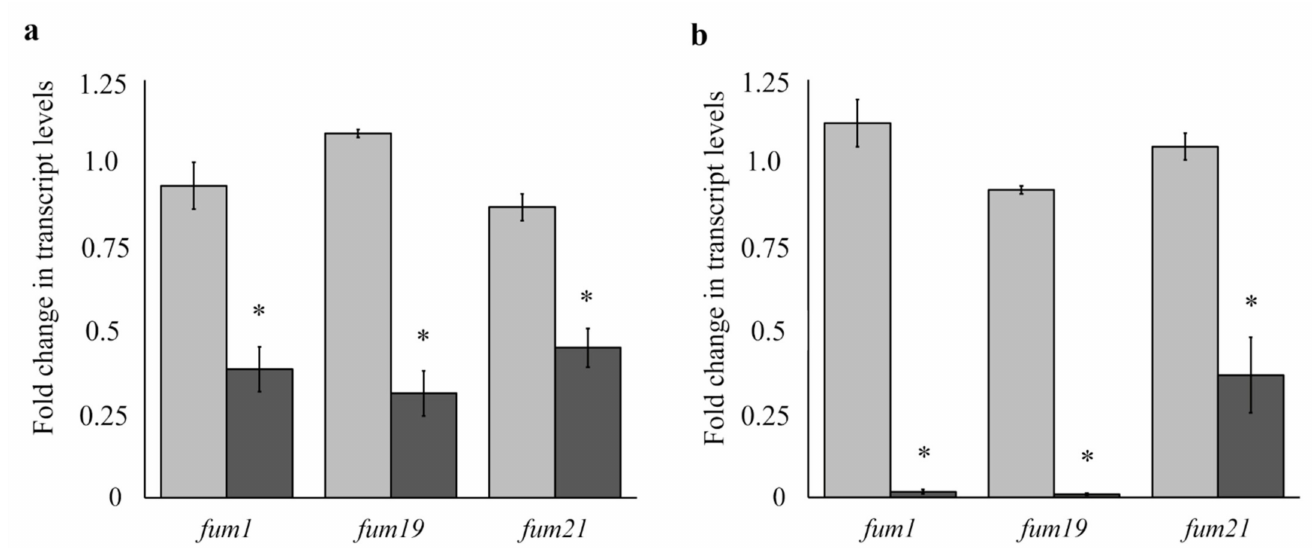
Figure 3. Effect of ELL 0.25 mM treatment on gene expression. Fold change in fum1 , fum19, and fum21 gene expression by FvH ( a ) and FvL ( b ) in response to β -CD control (0.75 mM; light gray bars) and ELL treatments (0.25 mM; dark gray bars). Due to data normalization, the expression level calculated for untreated control was set to 1.0. The fold change was calculated according to the expression values observed for each gene on untreated cultures. Bars represent the average value ± standard error. Bars with asterisks (*) are significantly different to untreated control according to Kruskal–Wallis and Dunn’s test ( p <